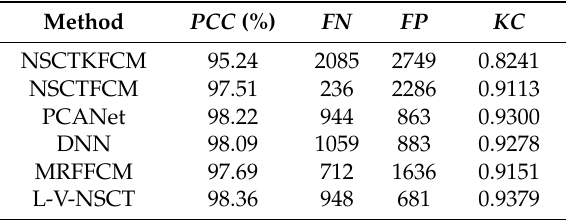
Table 1. Change detection results under evaluation by different